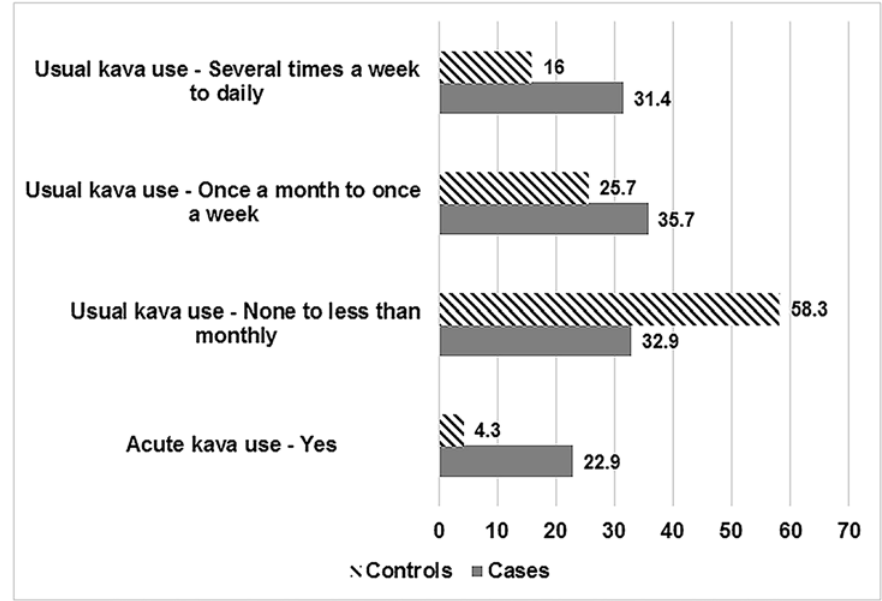
Fig 2. Distribution of acute (previous 12 hours) and usual (past 12 months) kava use among cases and